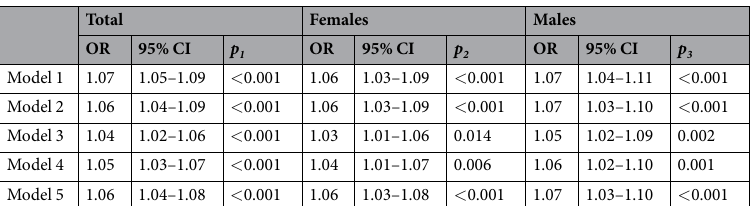
Table 3. Association between neck circumference (continuous data) and the risk of hypertension. OR, odds ratio; CI, confidence interval. Model 1, unadjusted; Model 2, adjusted for age, fasting blood glucose, smoking and drinking status, salt consumption, physical activity and family history of hypertension; Model 3, adjusted for model 2 + body mass index categories; Model 4, adjusted for model 2 + waist circumference categories; Model 5, adjusted for model 2 + waist-to-hip ratio.